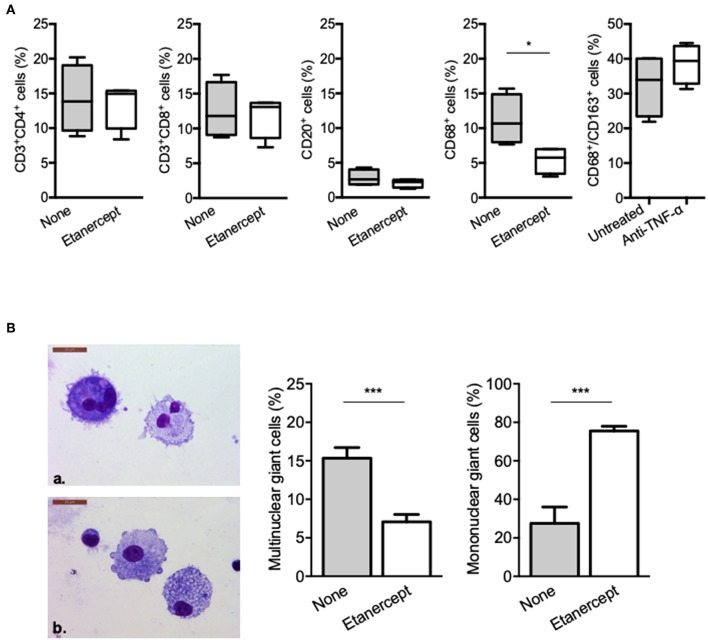
Etanercept affects granuloma-associated macrophage populations and MGCs. Isolated granuloma cells cultured in the presence or not of etanercept for 9 days were characterized using flow cytometry. (A) Graphical plots of the percentage of CD3+/CD4+, CD3+/CD8+, and CD20+ lymphocytes and CD68+ and CD68+CD163+ macrophages population (n = 4) *P < 0.05. (B) Isolated granuloma cells cultured in the presence or not of etanercept for 9 days were characterized by May-Grünwald-Giemsa staining. Representative image of multinuclear (upper panel) and mononuclear (lower panel) cells are shown, quantified and represented as the mean percentage ± SEM (n = 10) ***P < 0.001.